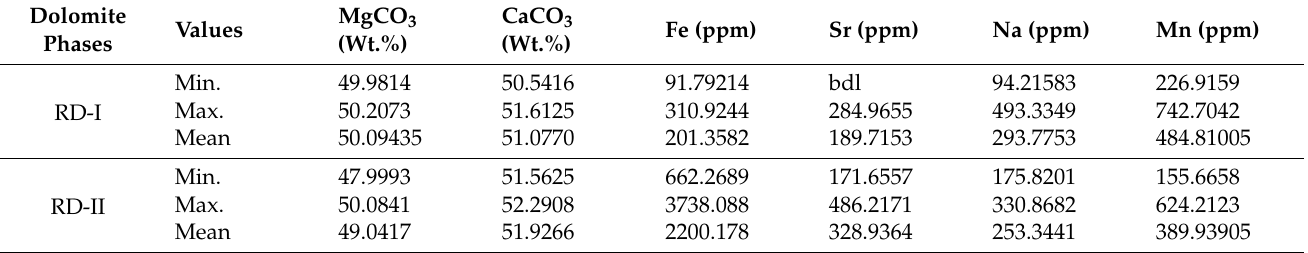
Table 3. Major and trace elemental composition of the studied dolomite and calcite